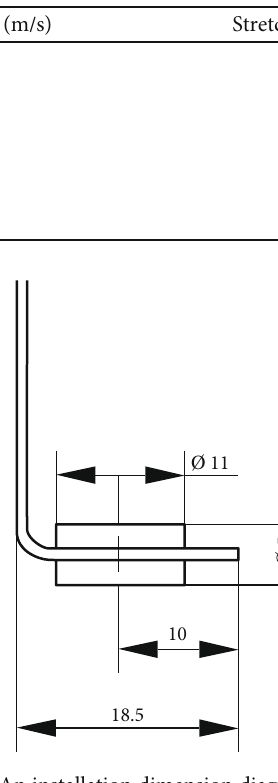
Table 2: The working condition of the riveting hole of the